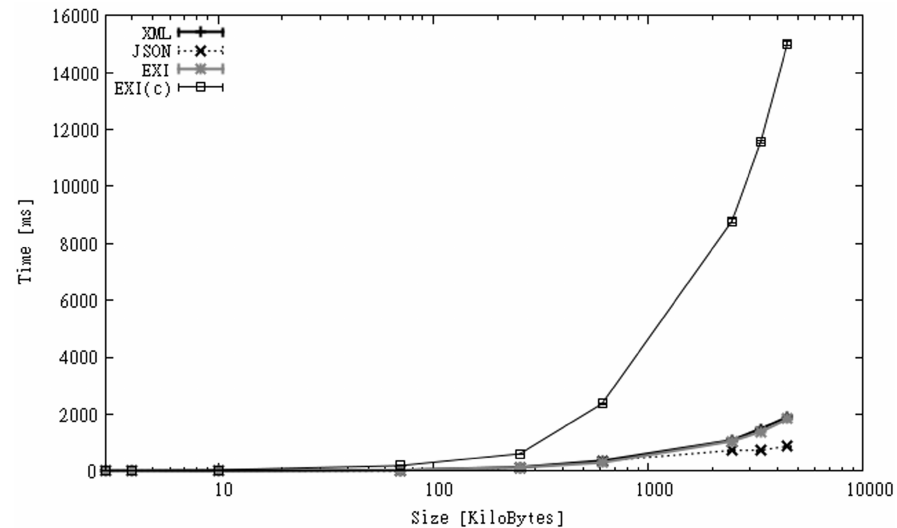
Figure 7. Parsing time for SGS2 smartphone (OBS